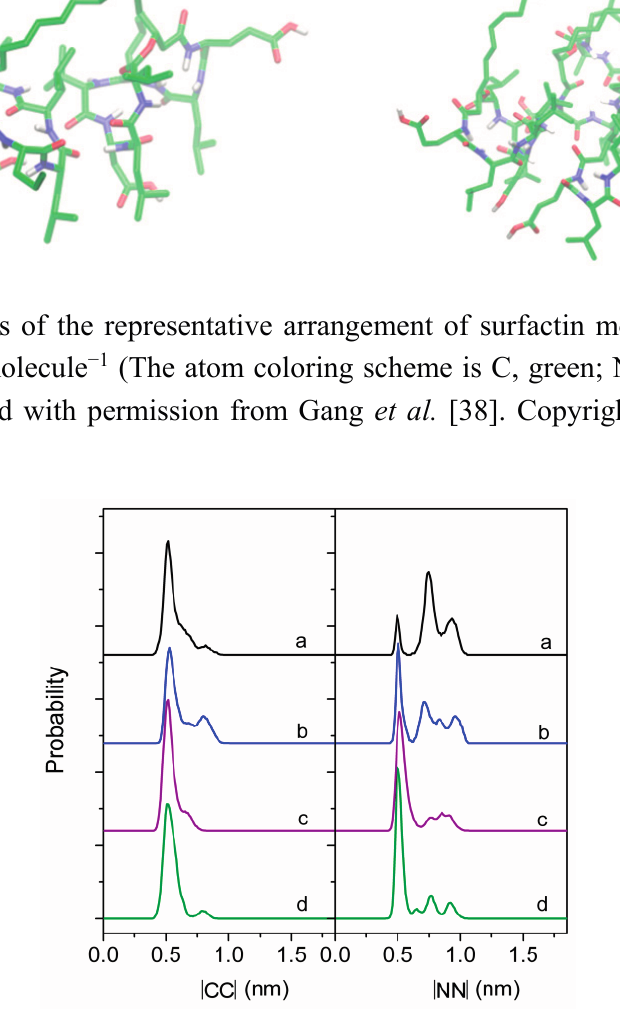
Figure 4. Normalized probability distribution of CC and NN magnitudes (a–d corresponds to the interfacial concentration of 2.20, 1.50, 1.20, and 0.95 nm 2 ·molecule − 1 , respectively; CC, the vector connecting the β carbon atom of the fatty acid residue and the α carbon atom in Val 4 ; NN, the vector connects the nitrogen atom of Leu 2 and the nitrogen atom of Leu 6 ). Reprinted with permission from Gang et al. [38]. Copyright (2011) American Chemical